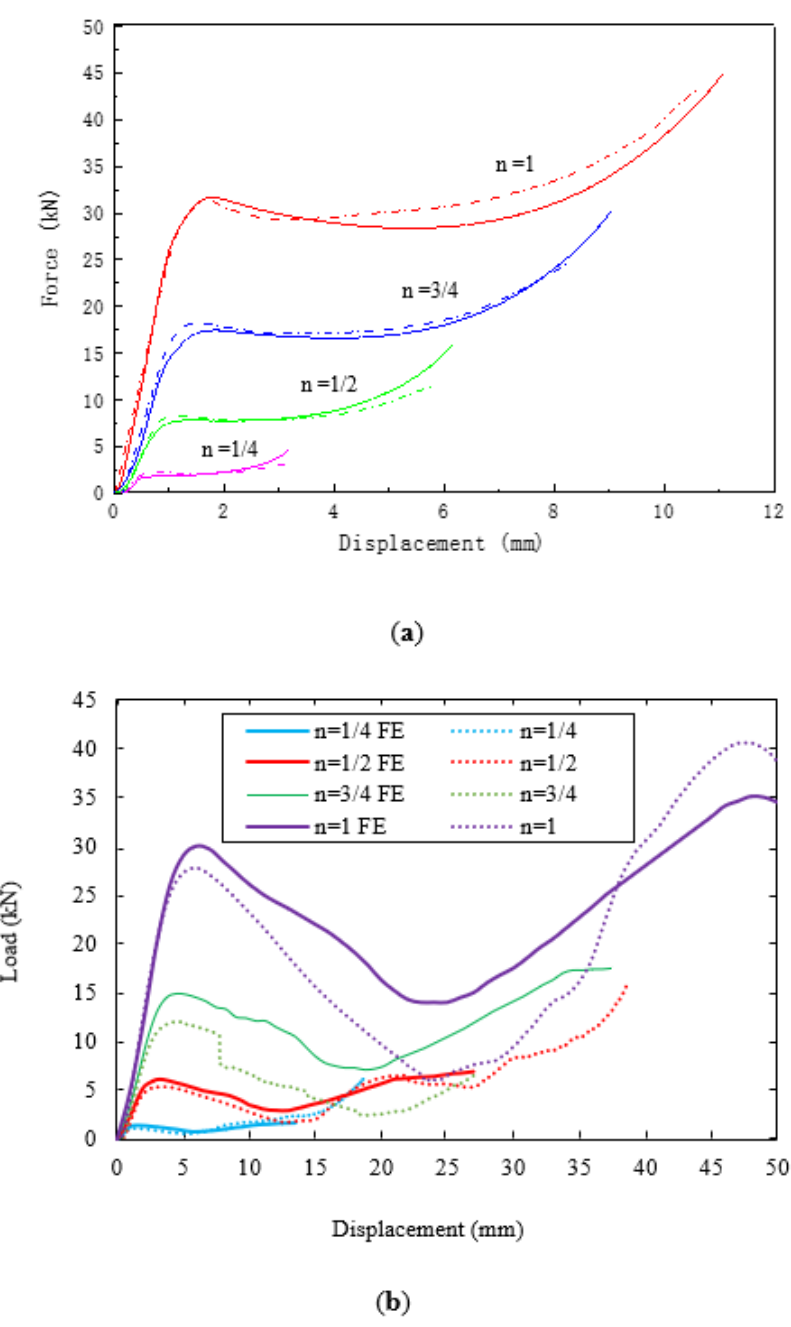
Figure 14. Comparison of the predicted (dashed lines) and experimental (solid lines) force– displacement traces following compression tests on ( a ) the four scaled sizes PLA cubes and ( b ) the lattice structures.